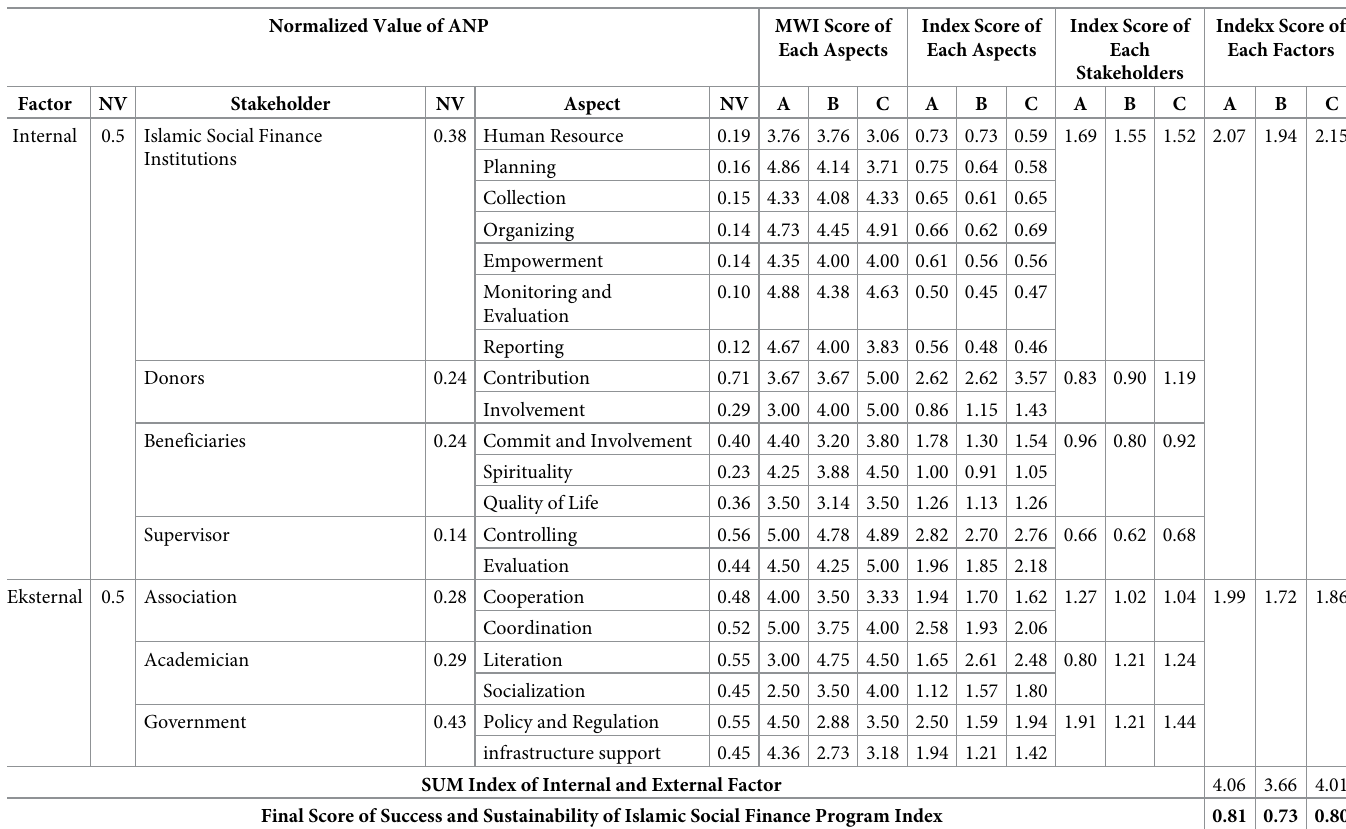
Normalized Value of ANP MWI Score of